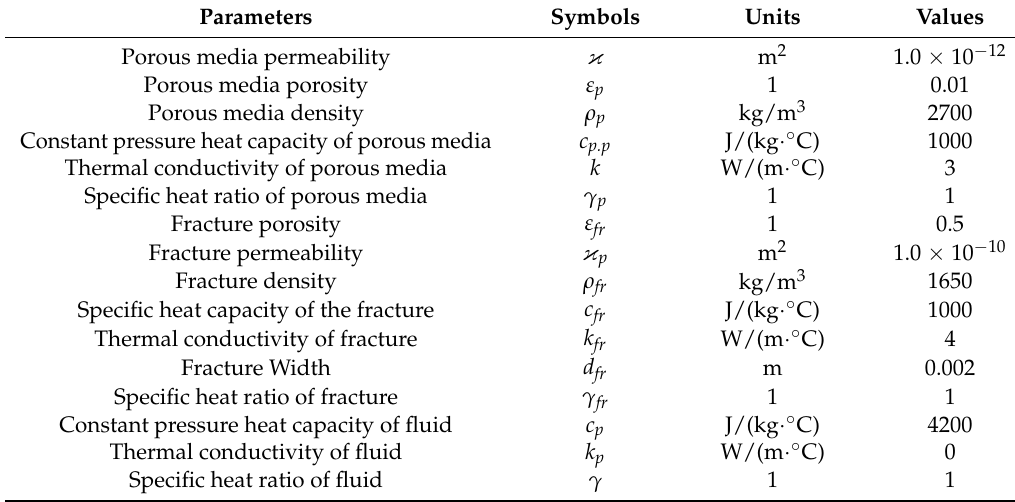
Table 3. Material parameters of enhanced geothermal system.